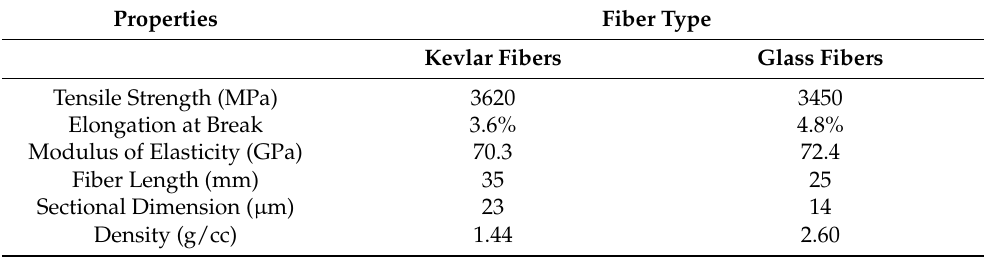
Table 3. Physical and mechanical properties of fibers ( DuPont™ Kevlar ® 29 Aramid Fiber , n.d.; E-Glass Fiber , Generic ,